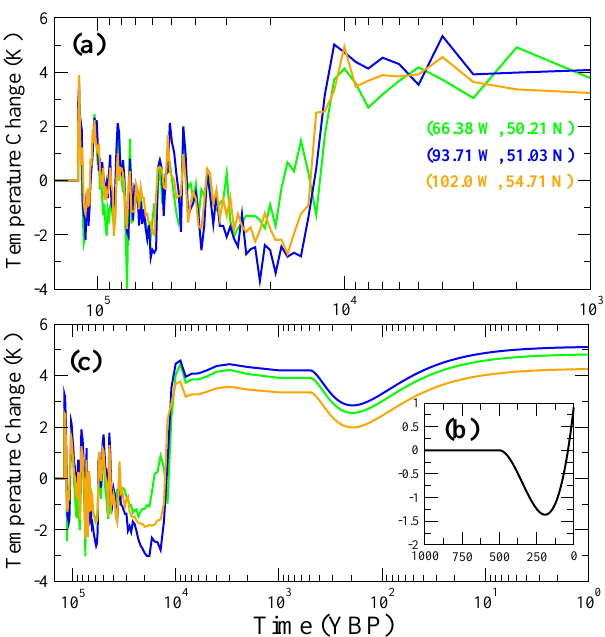
Figure 4. (a) Surface forcing function: temperature change from Fig.4. (a)Surfaceforcingfunction: TemperaturechangefromGSMforthreeofgivensites. (Insertb)Theoret- icalGSTHforthemostrecent1000yearstobeusedascontrol. (c)Superpositionoftemperaturechangesfrom the GSM for three of the given sites. ( b ) Theoretical GSTH for the (a)and(b),i.e.,theforcingvariationatthesurface. most recent 1000 yr to be used as a control. (c) Superposition of temperature changes from (a) and (b) , i.e., the forcing variation at Figure4b. Forconsistency,weusedthesamesynthetichistoryasdescribedinBeltramietal.(2011) the surface. overthefulldomain,despitethefactthatthesehistoriesvaryspatiallyoverourexperimentaldomain. Thespatiallyhomogenouslast-millenniumhistoryneverthelesssimplifiesourinterpretationofLGC impacts on BTP analyses by isolating only the spatial heterogeneity of the LGC basal temperature 320 changes within our analysis.